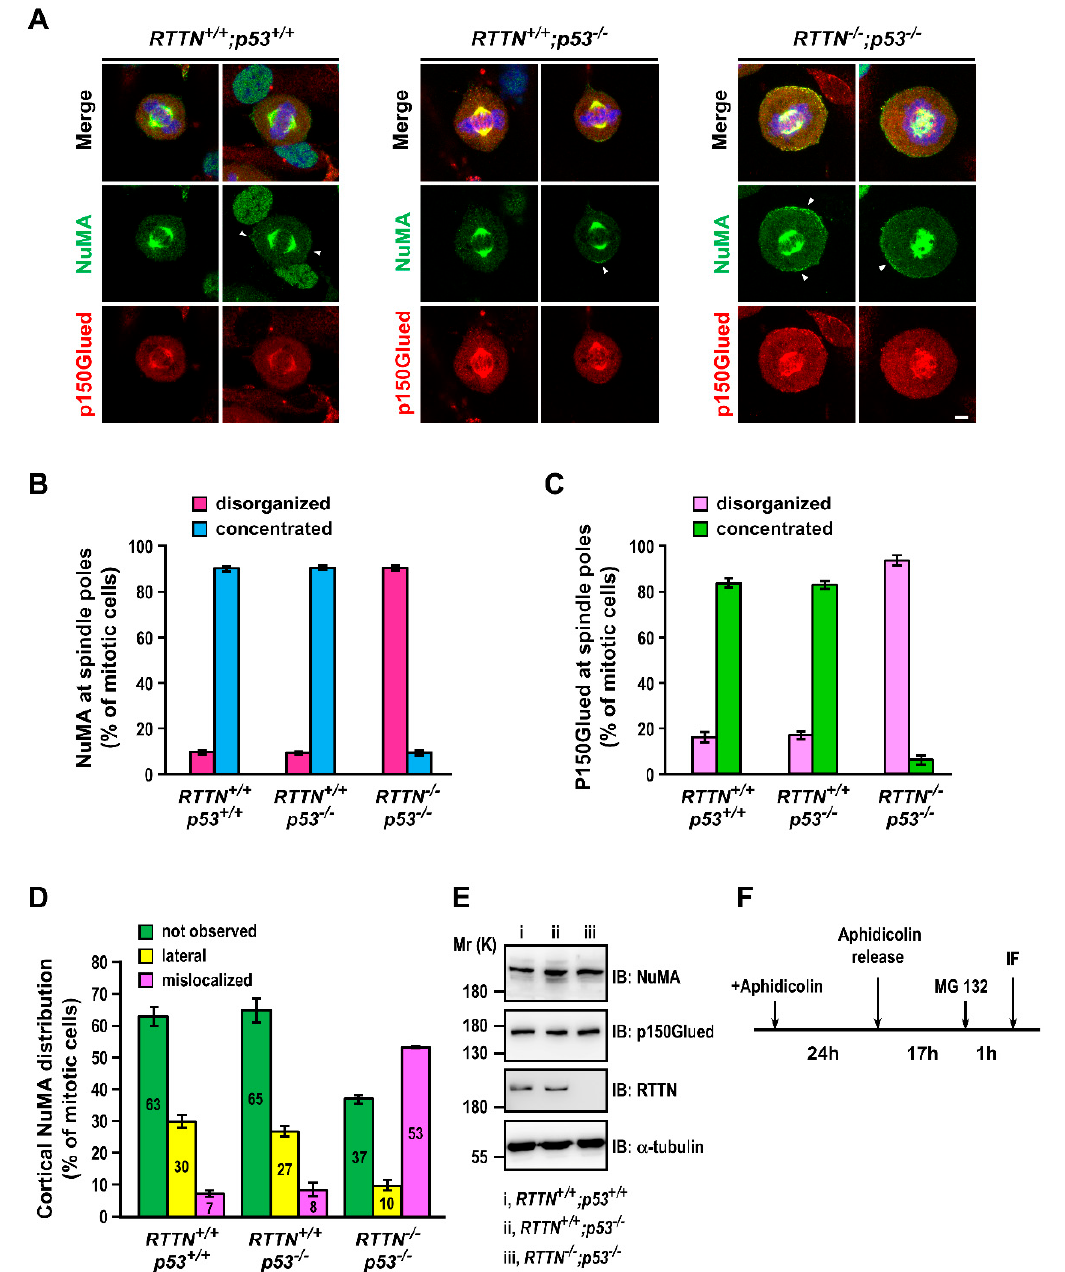
Figure 3. Loss of RTTN altered NuMA/p150Glued congression to the spindle poles and perturbs NuMA cortical localization during mitosis. RPE1-based RTTN +/+ ; p53 +/+ , RTTN +/+ ; p53 − / − , or RTTN − / − ; p53 − / − mitotic cells were co-immuno-stained with anti-NuMA and anti-p150Glued antibodies, followed with confocal fluorescence microscopy ( A ). Arrowheads in ( A ) indicate the cortical NuMA. Histograms illustrating the percentages of mitotic cells with disorganized or concentrated NuMA ( B ) or p150Glued ( C ) at the spindle poles. Histograms in ( D ) illustrating the percentages of mitotic cells with various patterns of cortical NuMA distribution. We define the lateral distribution of NuMA as that NuMA localized at the cortical membrane, which is positioned laterally to the division axis. ( E ) RPE1-based RTTN +/+ ; p53 +/+ , RTTN +/+ ; p53 − / − , or RTTN − / − ; p53 − / − cell lysates were analyzed by Western blotting using the indicated antibodies. A representative image of each blot is shown in (E). The uncropped images of Western blots are shown in Supplementary Figure S1. ( F ) Schematic of the procedure used to enrich mitotic cells. Data are represented as the mean ± SEM from three independent experiments. Scale bars: 5 µ